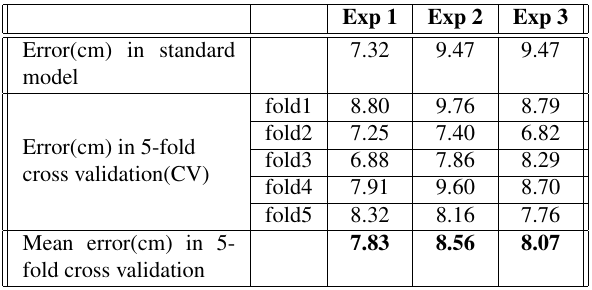
Table 2. Summary of